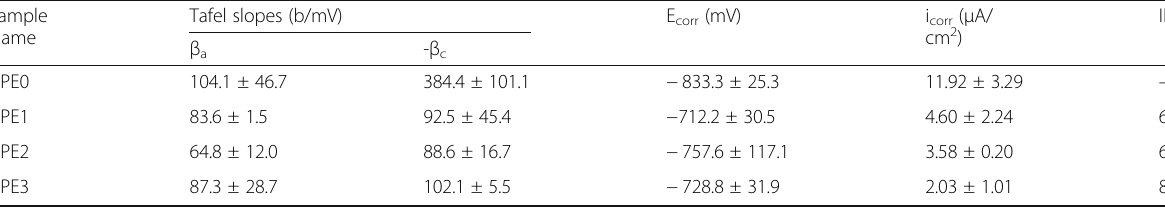
Table 4 Electrochemical parameters fitted by using Tafel polarization